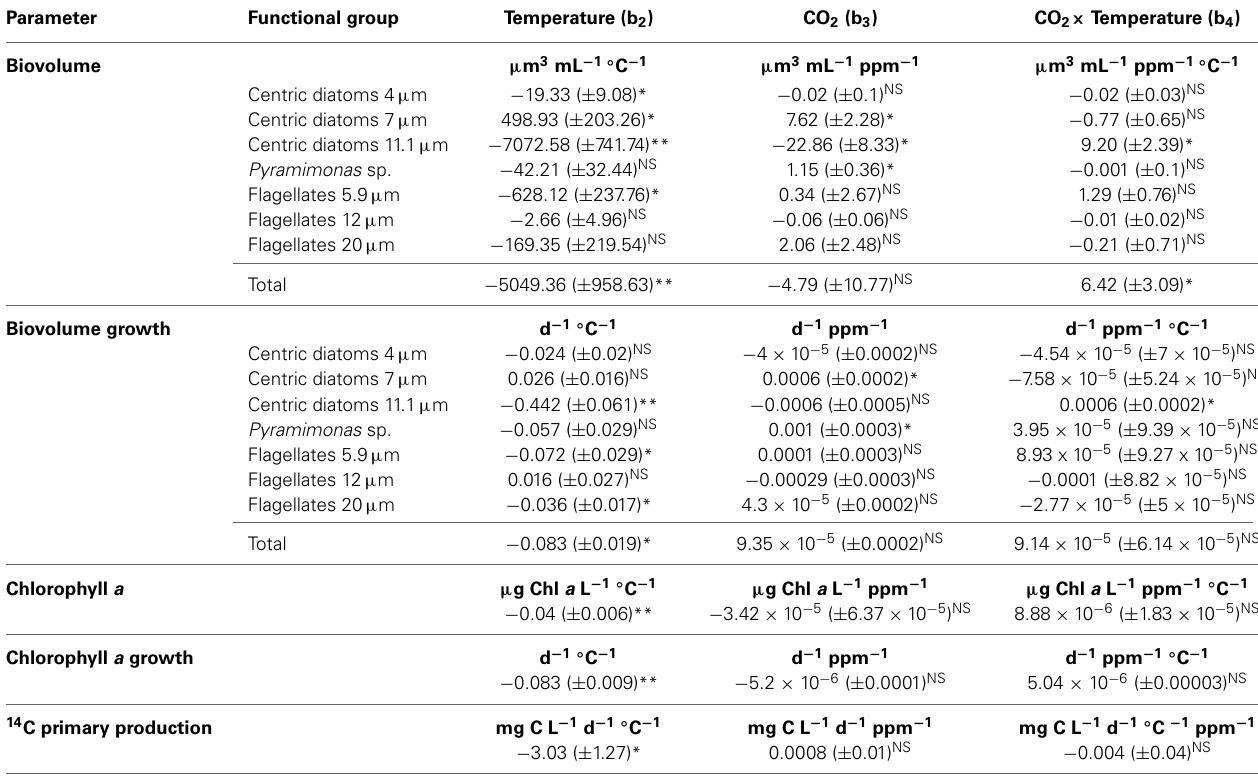
Table 2 | The mean ± SE effects of experimentally increased temperature, p CO 2 and their interaction on the biovolume of different functional groups in the community, chlorophyll a concentration and primary production, were estimated using the general linear model described in the Materials and Methods